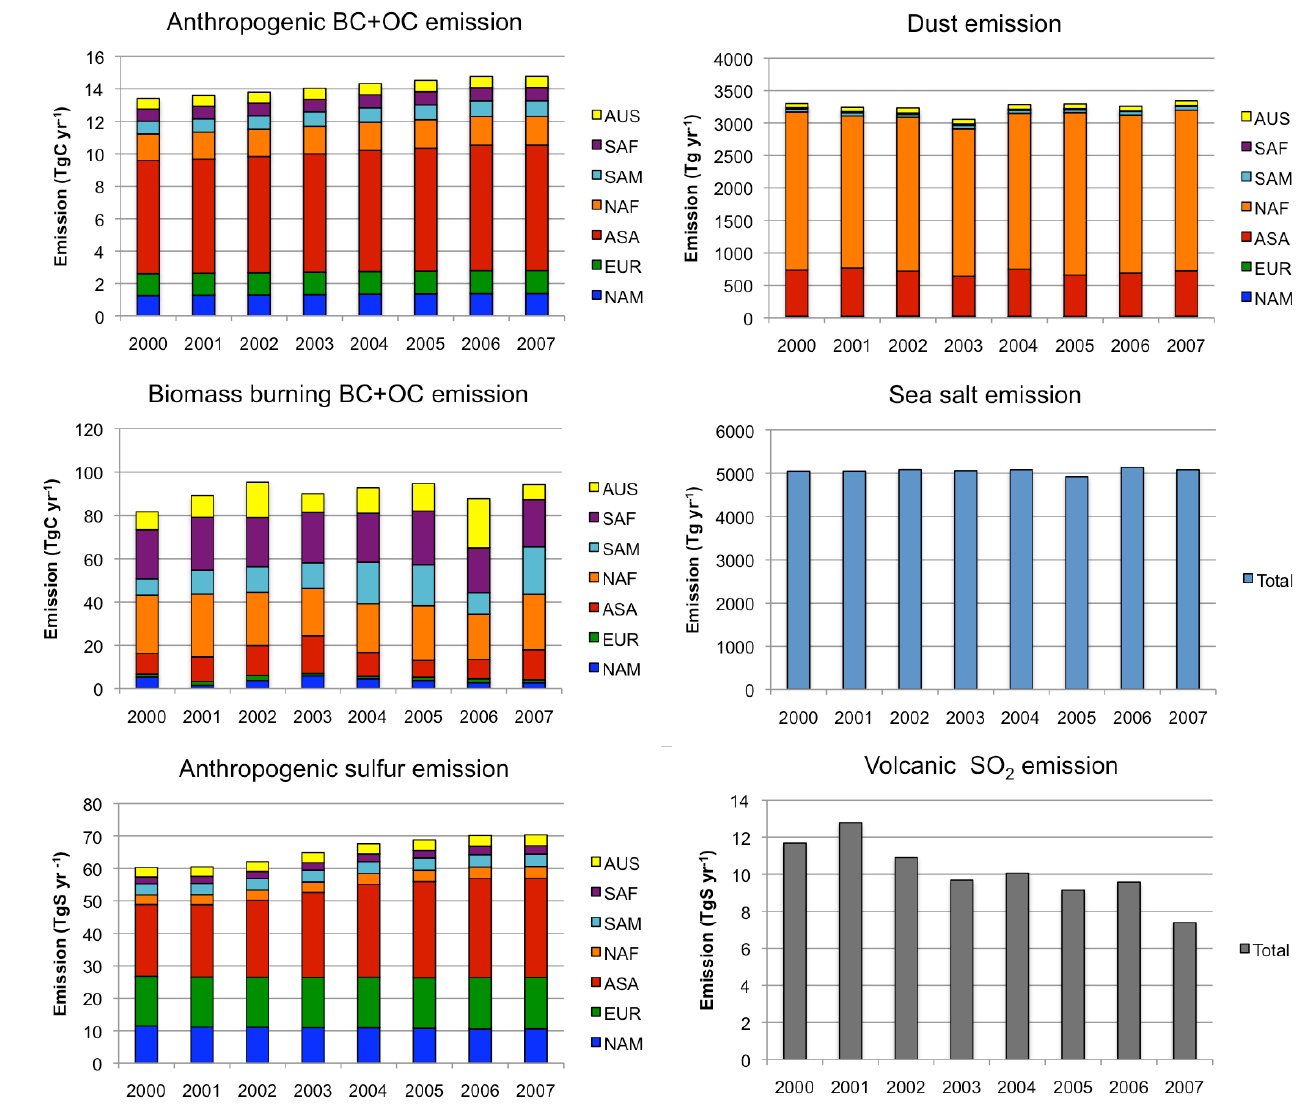
Figure 1. Fig. 1. Emissions of aerosols and precursor gases from their major sources and source regions from 2000 to 2007, annual total amount. NAM = North America, EUR = Europe, ASA = Asia, NAF = northern Africa and Middle East, SAM = South America, SAF = southern Africa, AUS = Australia/New Zealand and countries in the tropical South Pacific. See Fig. 4 for region